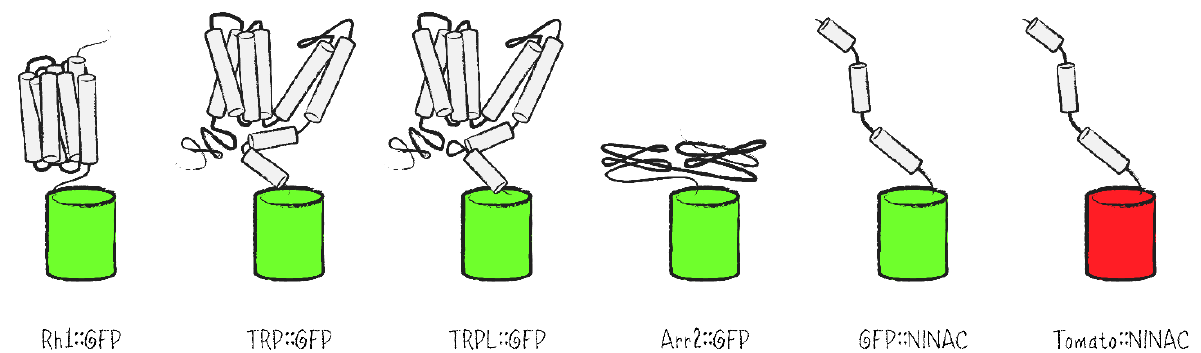
Figure 4. Schematic representation of common FP fusion proteins with applications in the research of the Drosophila visual system. Shown are FP fusions with rhabdomeral proteins (Rh1::GFP, TRP::GFP, TRPL::GFP, Arr2::GFP, GFP::NINAC, tomato::NINAC) for visualization of photoreceptor cells within the context of Drosophila mosaic eyes or as read-out for genetic screenings related to protein abundance, localization and trafficking as well as rhabdomere and cell integrity.